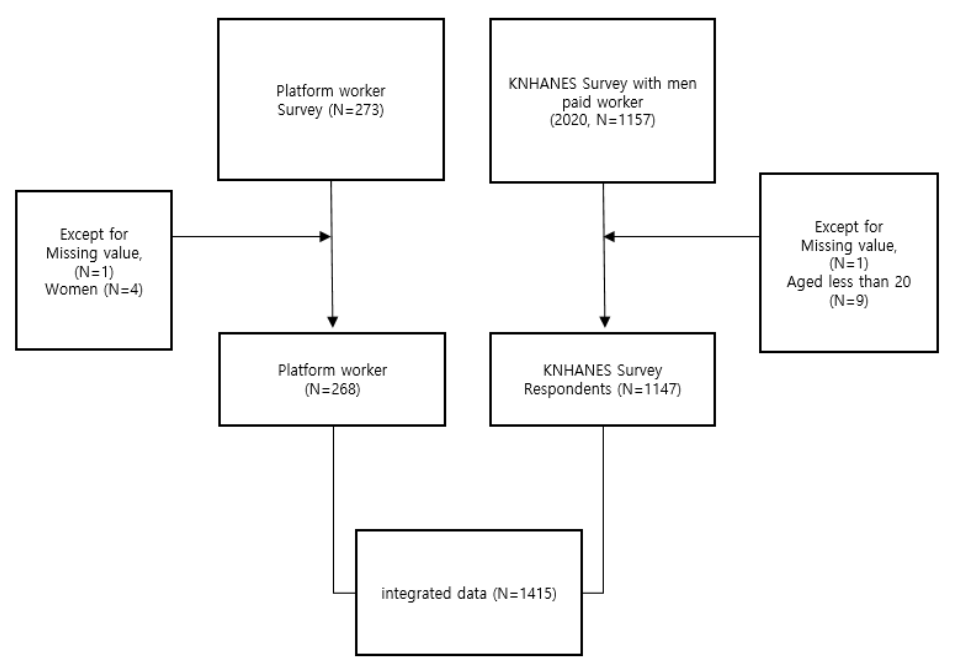
Figure 1. Participant enrollment